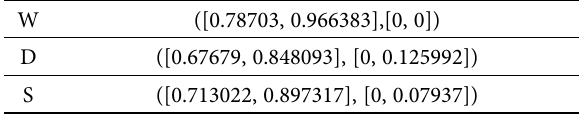
Table 8. Average values with respect to